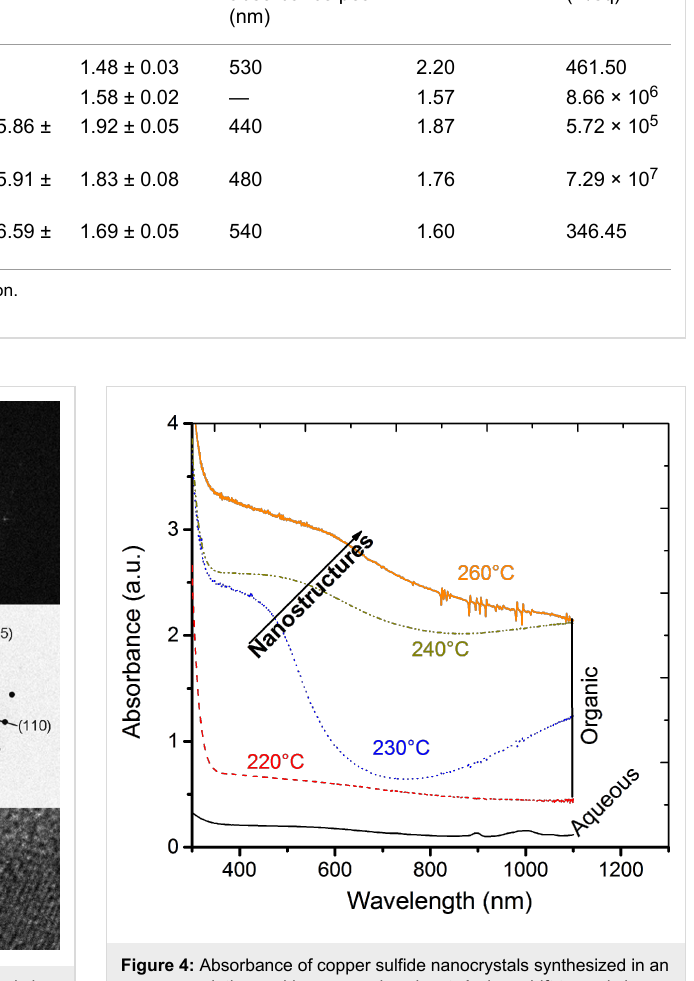
Table 2: Summary of the morphological, optical, and electrical properties of Cu x S samples. samples/temperature (°C)